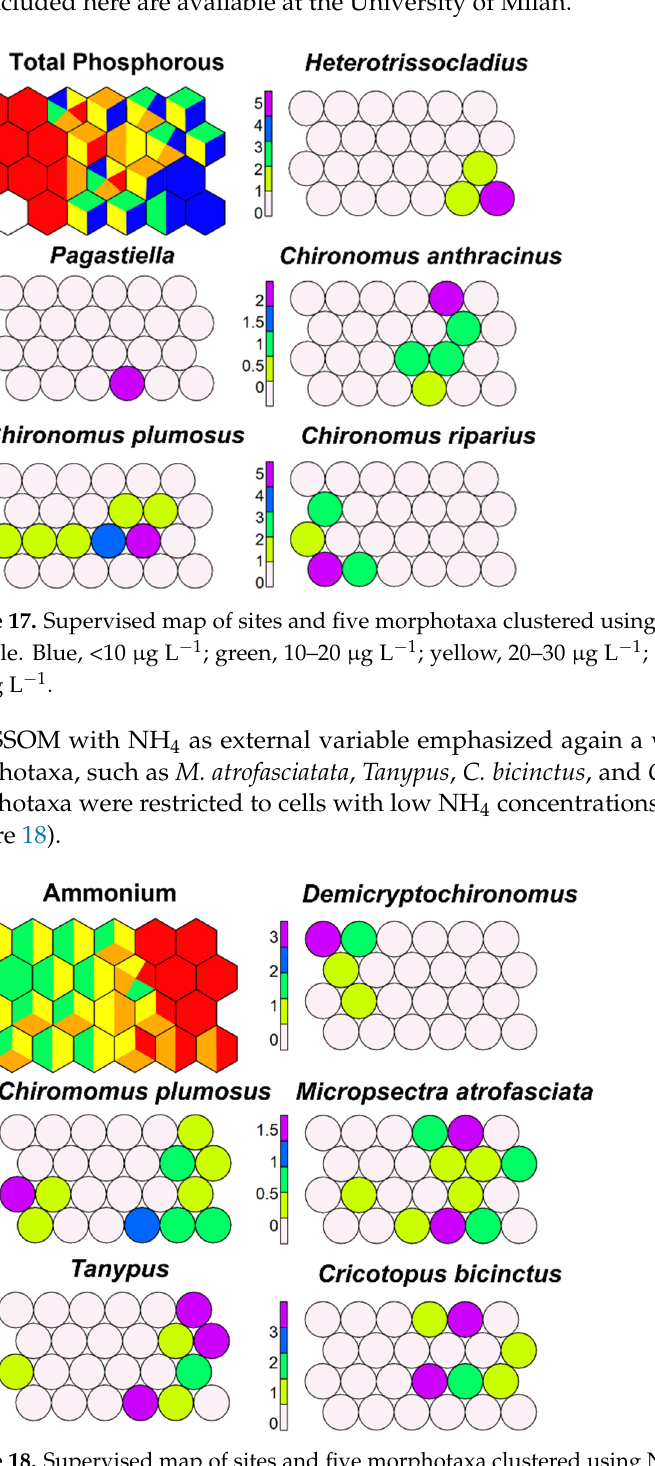
Figure 16. Supervised map of sites and five morphotaxa clustered using conductivity (in µS cm − 1 ) as external variable. Blue, <100 µS cm − 1 ; green, 100–200 µS cm − 1 ; yellow, 200–300 µS cm − 1 ; orange, 300–400 µS cm − 1 ; red, >400 µS cm − 1 .